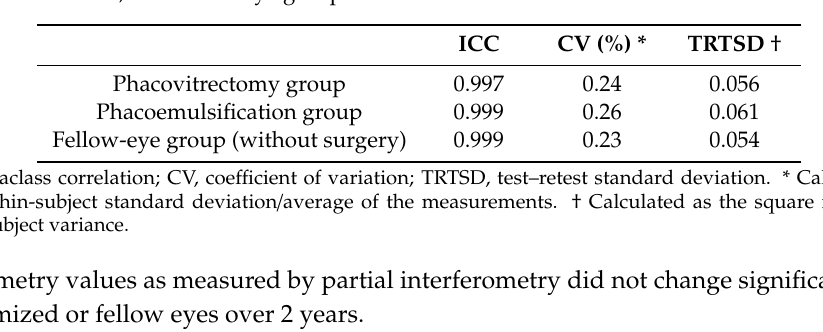
Table 2. Long-term reproducibility of axial length measurements in the phacovitrectomy, phacoemulsification, and fellow-eye